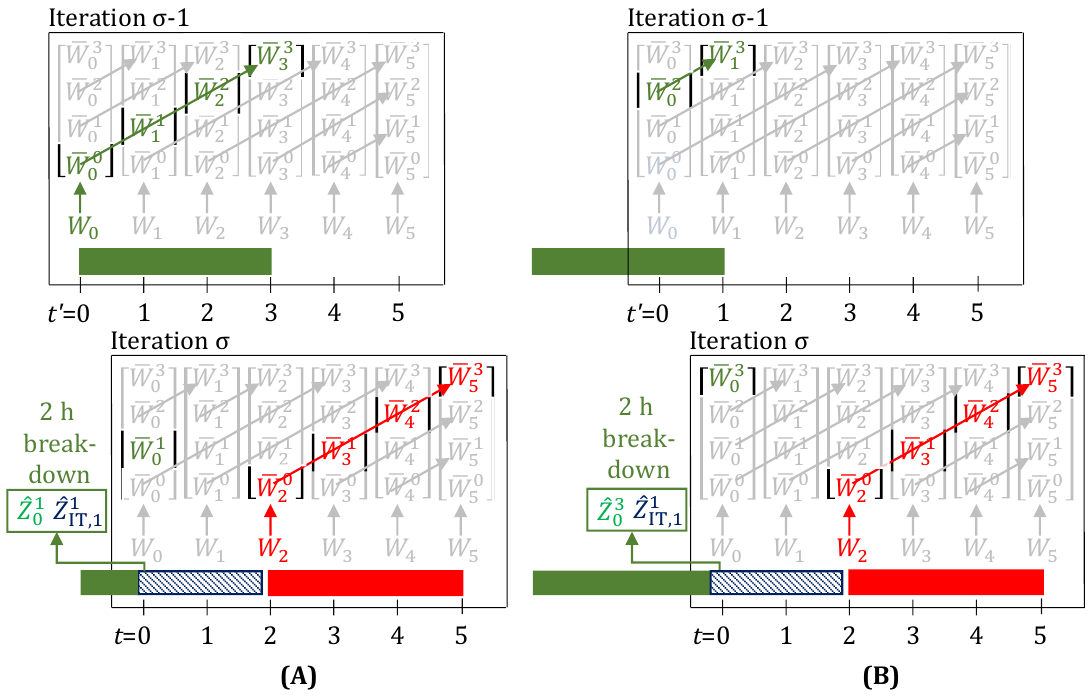
Figure 5. When a breakdown is observed, further evolution of the task-states for the task (the green trajectory), running on the unit that broke, stops. Here, τ for the task is 3 and the unit downtime (blue) is 2 h.